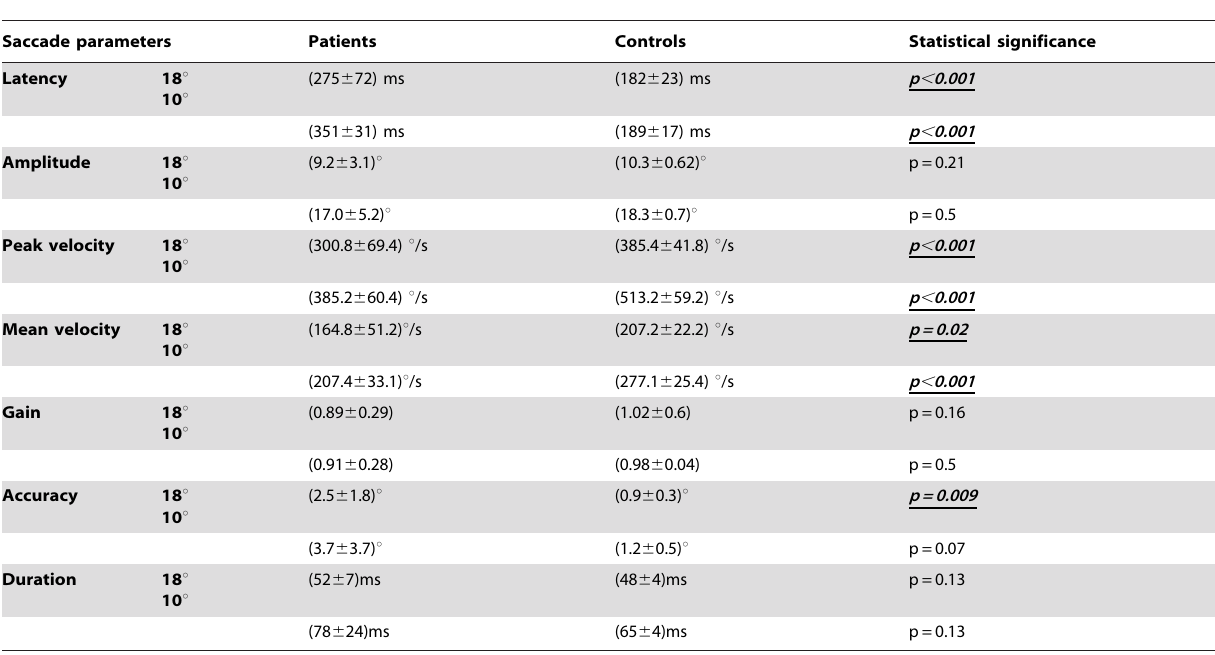
Table 3. Main saccade parameters of Patients Vs Controls (significant data